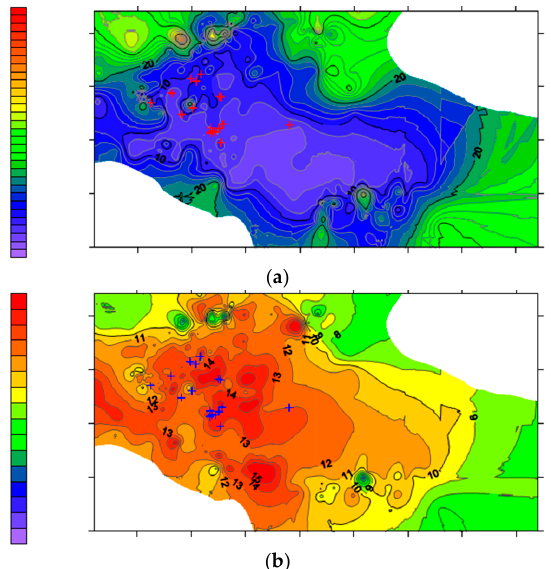
Figure 9. ( a ) Ash content and locations of coal bursts source in thickness layer A; and ( b ) Calorific value of coal and locations of coal bursts source in thickness layer A.